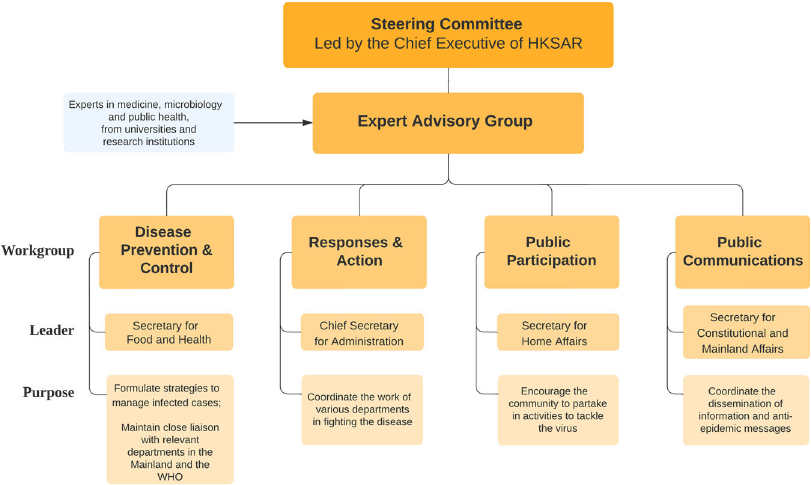
Fig. 5 The four ‘ workgroups ’ under the Chief Executive ’ s Steering Committee. Four formal workgroups along with an informal expert advisory group report to the steering committee and command centre, created and led by the Chief